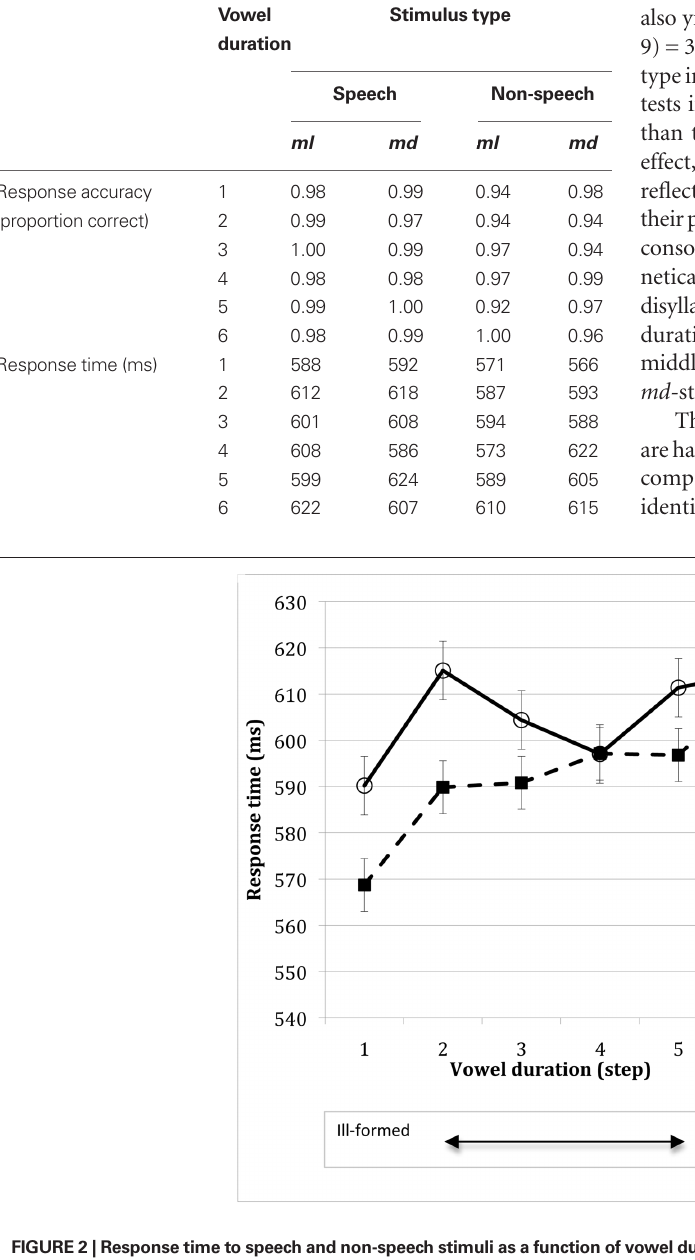
Table 1 | Mean response accuracy and response time to speech and non-speech stimuli in experiment 1.